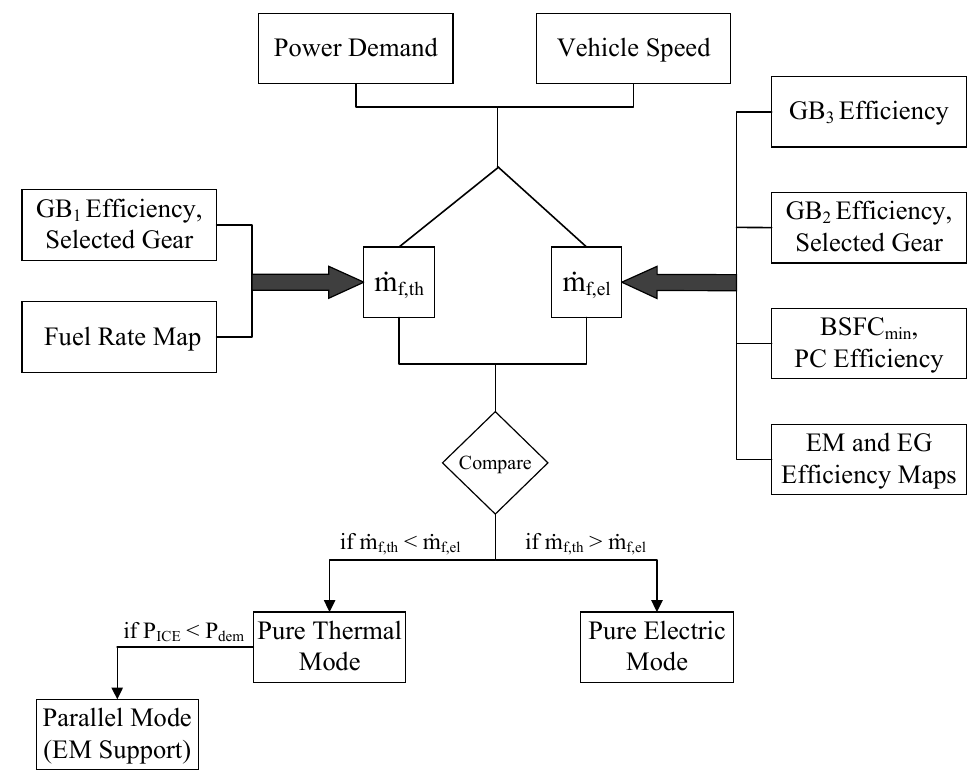
Figure 5. Flowchart schematizing the logic of